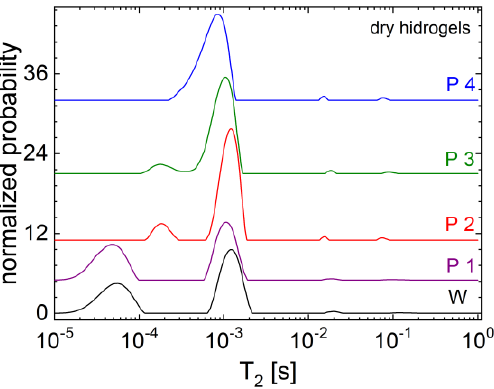
Figure 5. The T2 distributions of dry hydrogel samples containing 0 (black), 1 × (purple), 2 × (red), 3 × (olive), 4 × (blue) graphene.